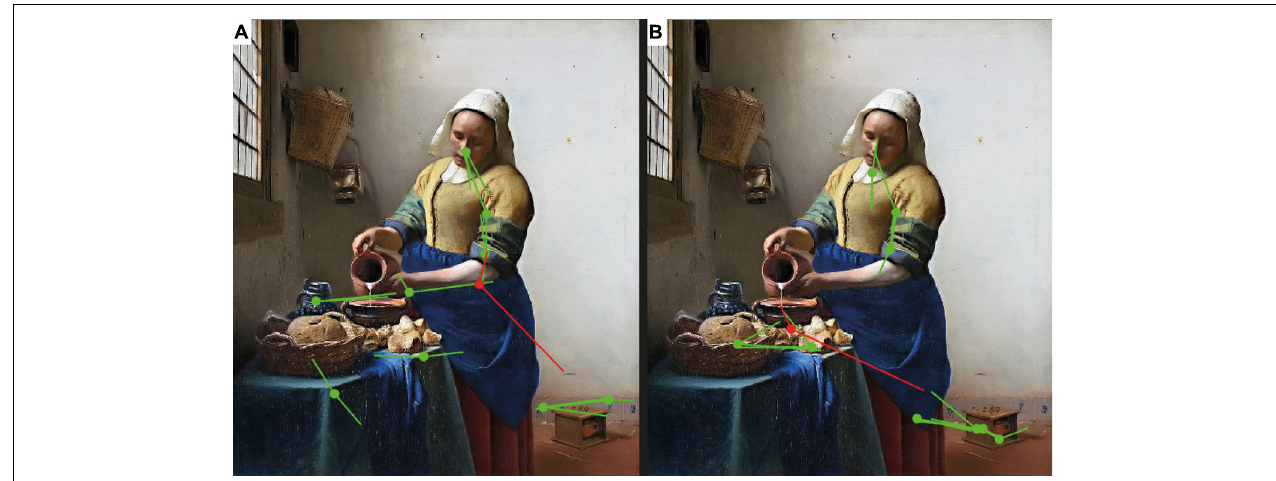
FIGURE 1 | Example of focal and ambient mode of visual processing from one of 32 non-experts (A) and one of 30 experts (B) recorded while viewing one of the 150 paintings included in the experiment (Johannes Vermeer, Woman with a Water Jug, 1660–1662, oil on canvas, 45.7 × 40.6 cm, Metropolitan Museum of Art, New York City, NY, United States). In green are marked long fixations ( > 180 ms) followed by short saccades ( ≤ 4 ◦ ); in red are marked short fixations ( ≤ 180 ms) followed by long saccades ( > 4 ◦ ).